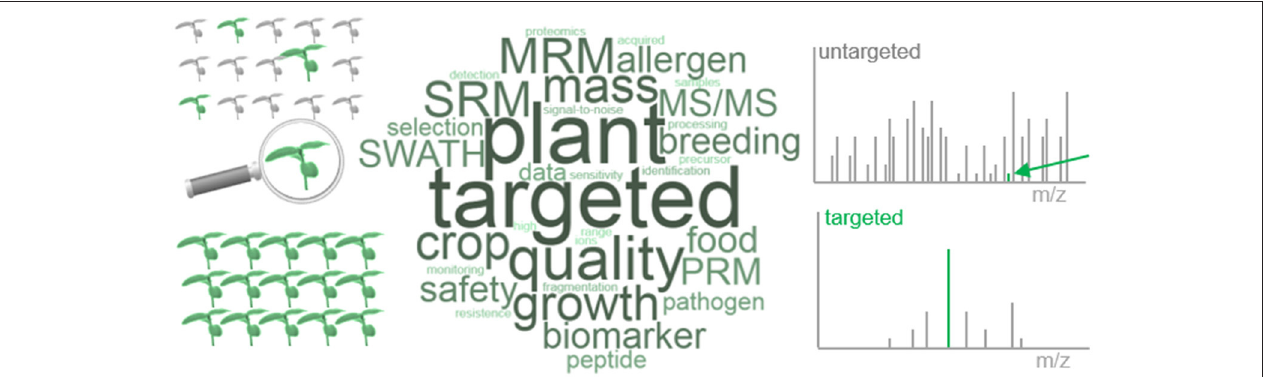
FIGURE 1 | Illustrative scheme of targeted proteomics in plants. Targeted proteomics provides higher reproducibility over conventional discovery approaches resulting in higher reproducibility of analyte detection in different individuals or communities (Left) . This is because the dynamic range constraint of precursor selection is minimized and signal-to-noise ratios improve with the selection of a specific m/z peak for further fragmentation (Right) . The word cloud names some plant specific targeted proteomics applications as detailed in the main